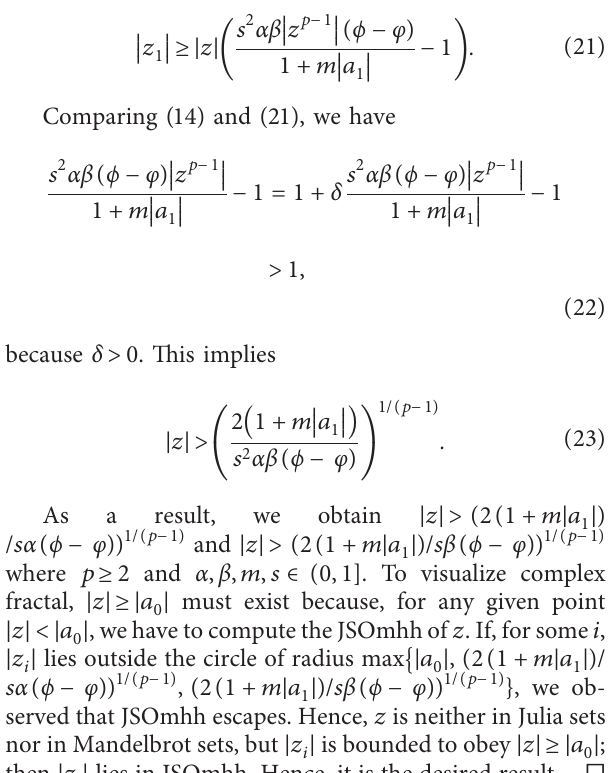
� 0 . 00122, a � 1 + i , a � 1 , a � 0 1 2 3 � 0 . 001019, a � 1 + i , a � 1 , a � 0 1 2 3 � 0 . 000085 i , a � 1 + i , a � 45 , a � 0 1 2 3 � 1 + i , a � 45 , a � 50, a, b, s, m 1 2 3 � 0 . 09956 + 0 . 27 i , a � 2 , a � 1 , 0 1 2 � 0 . 0489 + 0 . 366 i , a � 2 , a � 1 , 0 1 2